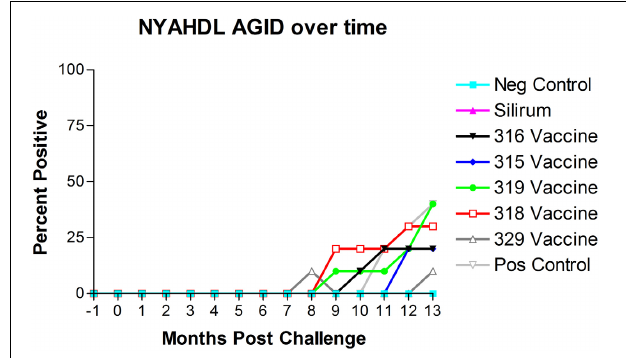
FIGURE 5 | New York Animal Health Diagnostic Laboratory (NYAHDL) AGID test results over time. The NYAHDL AGID is an agar gel immunodiffusion test for measuring serum antibody to Mycobacterium avium subsp. paratuberculosis. Note that no animals in the Silirum® vaccine group and only 1 animal in the 329 vaccine group (group 7) became AGID positive. ( − 1 is baseline bleeding, 0 is challenge date and 1–13 represents months post-challenge).